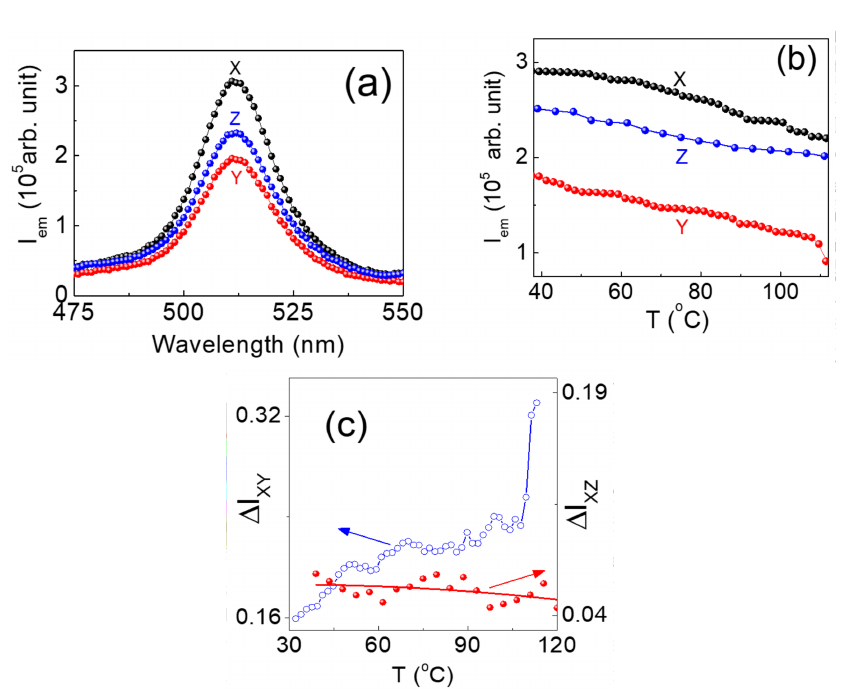
Figure 6. ( a ) Photoluminescence spectra at room temperature obtained with excitation at 404 nm for a thin film of the CsLC nanocomposite in the X, Y and Z geometries described in Figure 3. While the wavelength of peak emission remains the same, the magnitude varies with the geometry. ( b ) Thermal variations of the peak emissions I X , I Y and I Z, exhibiting a similar relation as the corresponding absorptions A X , A Y and A Z. . ( c ) Influence of temperature on ∆ I XY and ∆ I XZ , the two anisotropies of emission, as calculated using Equations (5) and